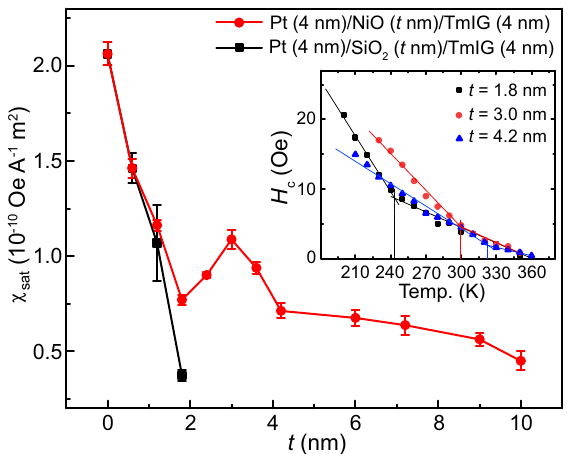
Figure 4. The dependence of the maximum SOT efficiency χ sat on the NiO thickness. Pt (4 nm)/SiO 2 ( t nm)/TmIG (4 nm) devices were measured for comparison. The inset shows the temperature dependence of the coercivity H c for the Pt (4 nm)/SiO 2 ( t nm)/TmIG (4 nm)